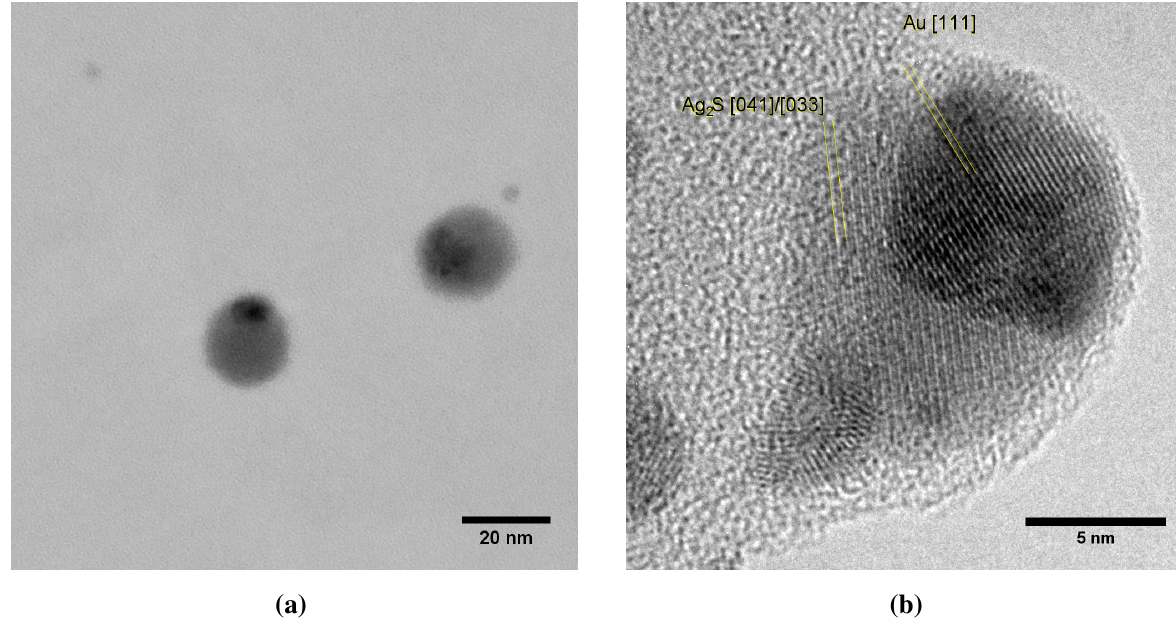
Figure 7. TEM micrograph of Au-on-Ag particles. ( a ) Two patchy particles and two clusters; ( b ) HRTEM image with lattice fringes of Ag Note the different scale bars of 20 nm in ( a ) and 5 nm in ( b